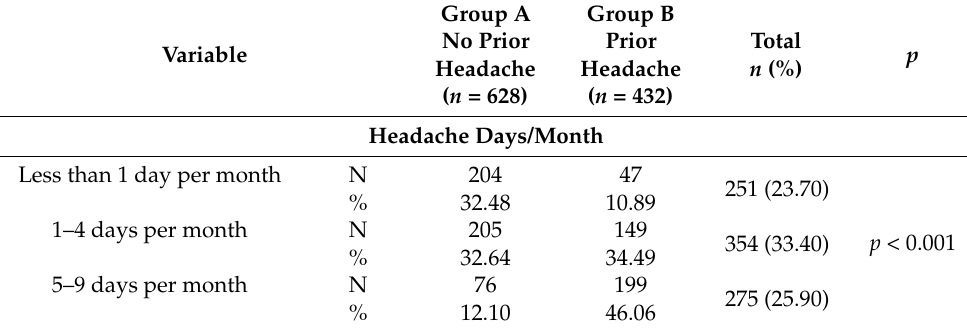
Table 3. Comparison of Headache Characteristics Among Healthcare Providers using the Chi- Square